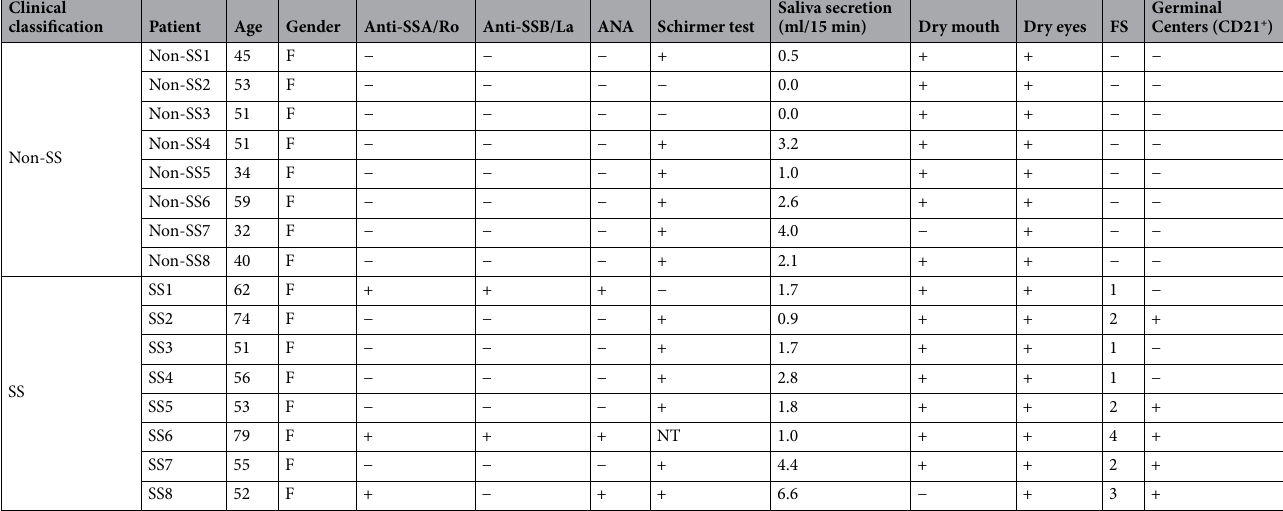
Table 1. Clinical characteristics of patients whose salivary gland biopsies were analyzed by RNAseq. ANA antinuclear antibodies; Saliva secretion (unstimulated flow); normal flow > 1.5 ml/15 min; Schirmer test positive when reduced tear secretion (objective test); Dry mouth and dry eyes, subjective symptoms from the patient, FS Focus Score, NT not determined. Germinal center-like structures may result from the deregulated proliferation and infiltration of lymphocytes in glandular